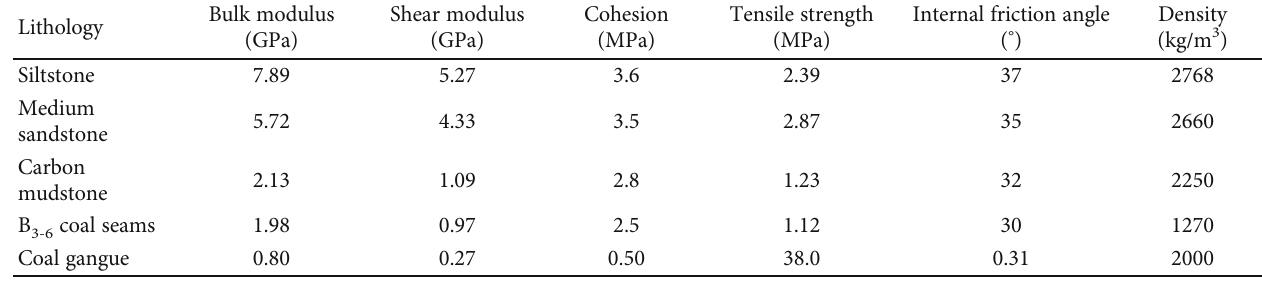
Table 1: Coal and rock mechanical parameters.